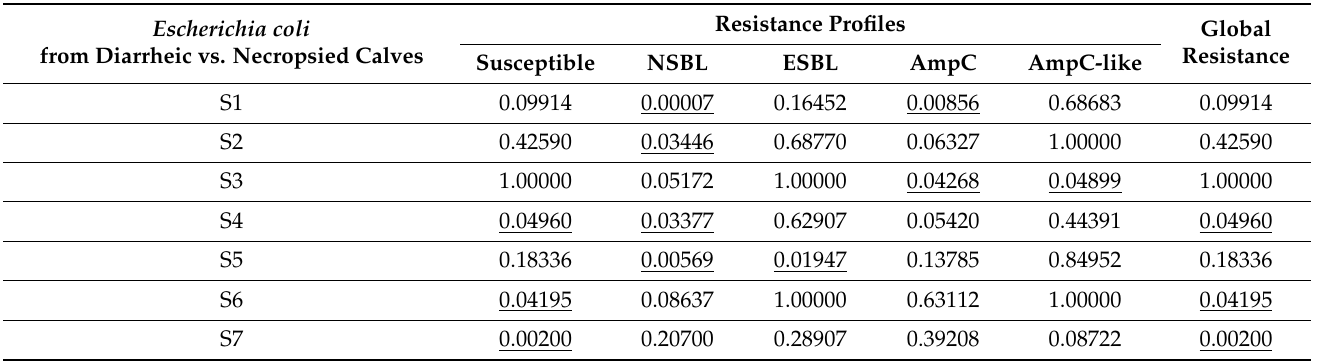
Table 4. Results of Fisher’s exact test ( p -value) for each resistance profile of Escherichia coli , depending